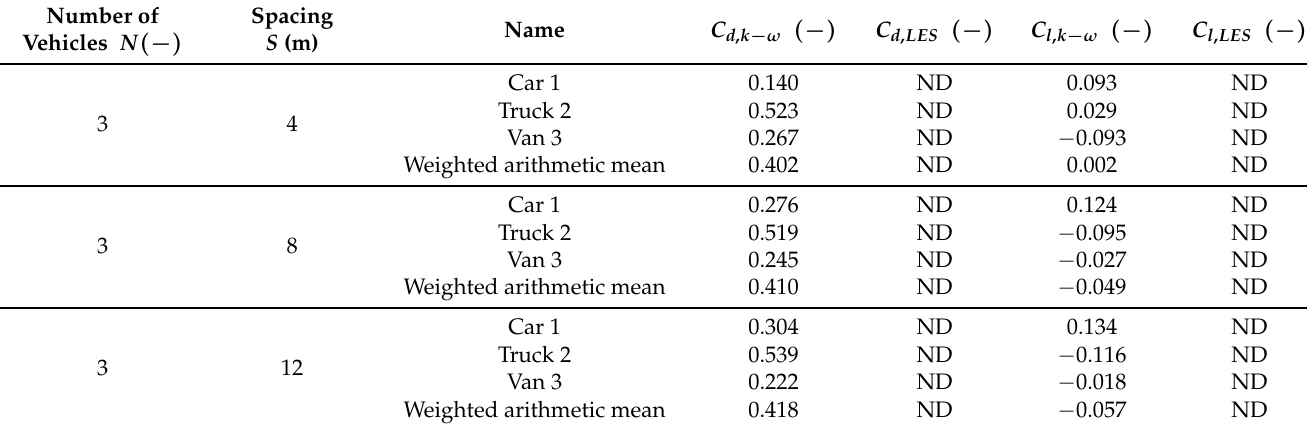
Table A3. Drag coefficient and lift coefficient of vehicles in heterogeneous columns (Car–Truck–Van).